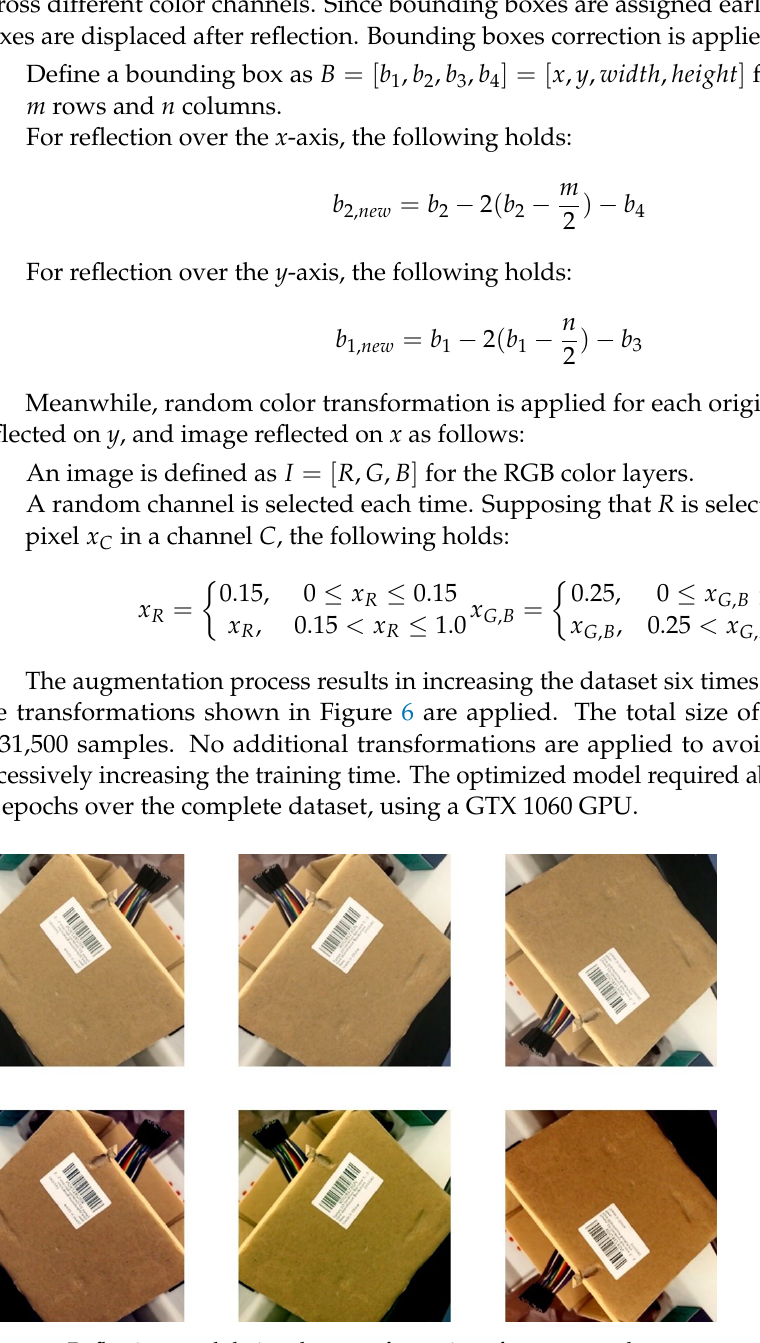
Figure 6. Reflections and their color transformations for one